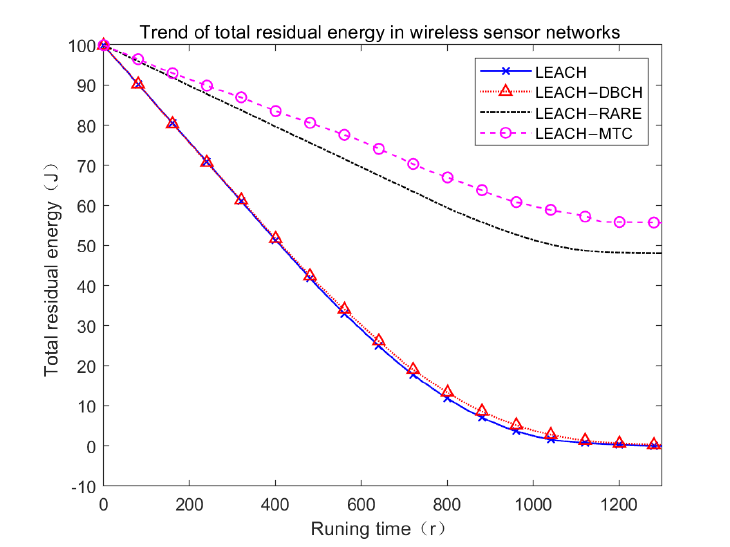
Figure 7. The variation of network residual